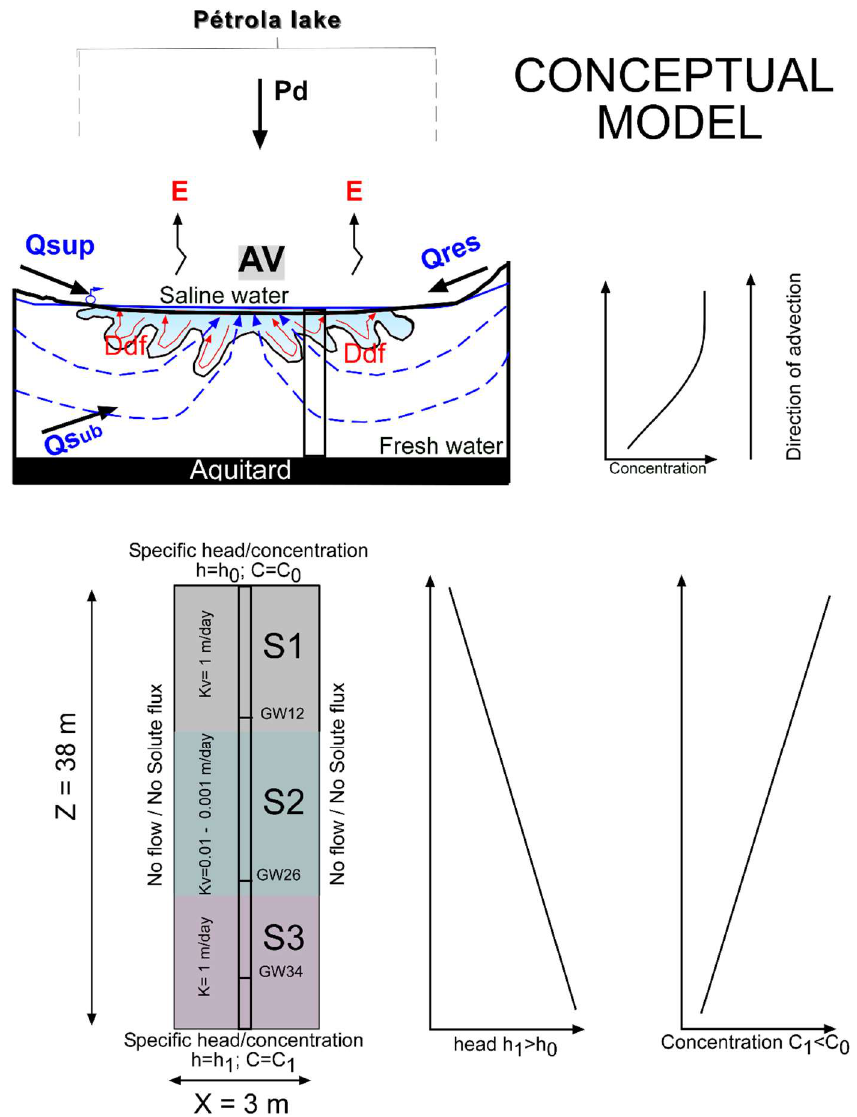
Figure 5. Simplified conceptual model of the relationship between hypersaline lake and freshwater